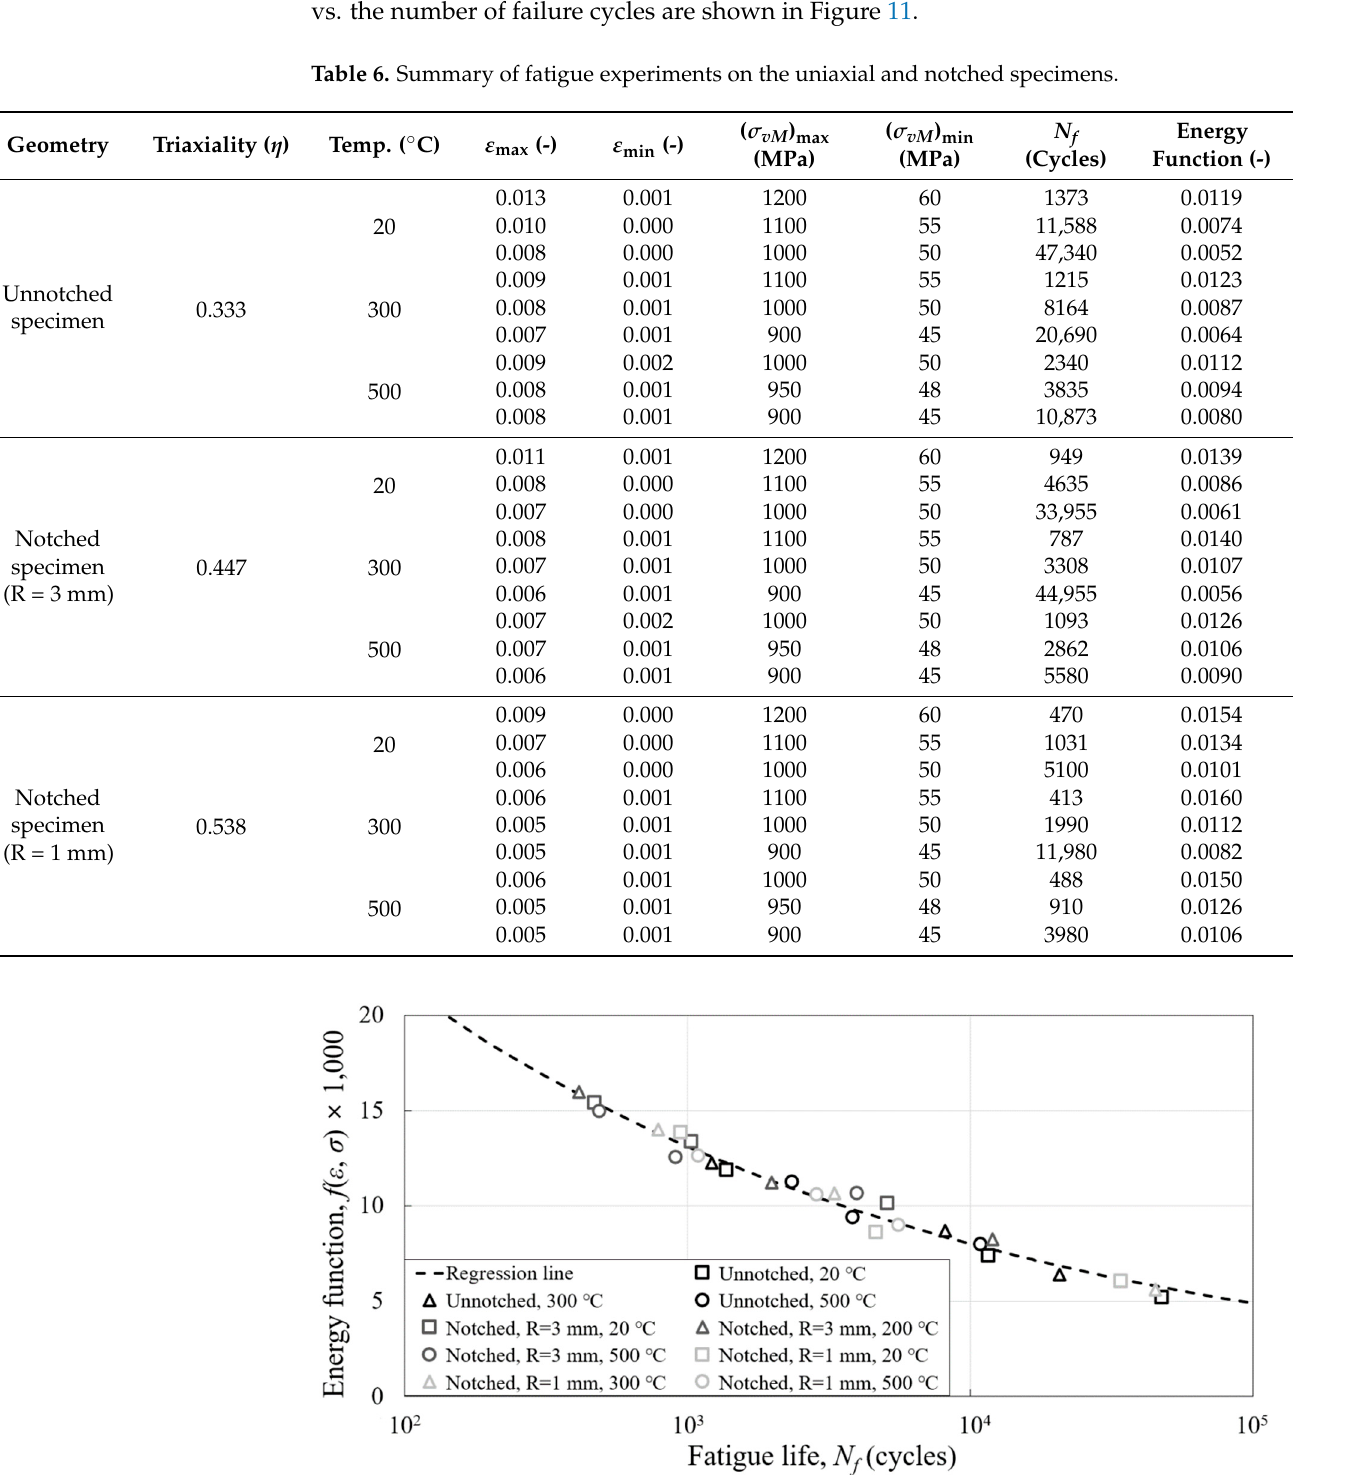
Figure 11. Energy function vs. fatigue life curve of the AISI H13 hot work tool steel (log–linear scale).